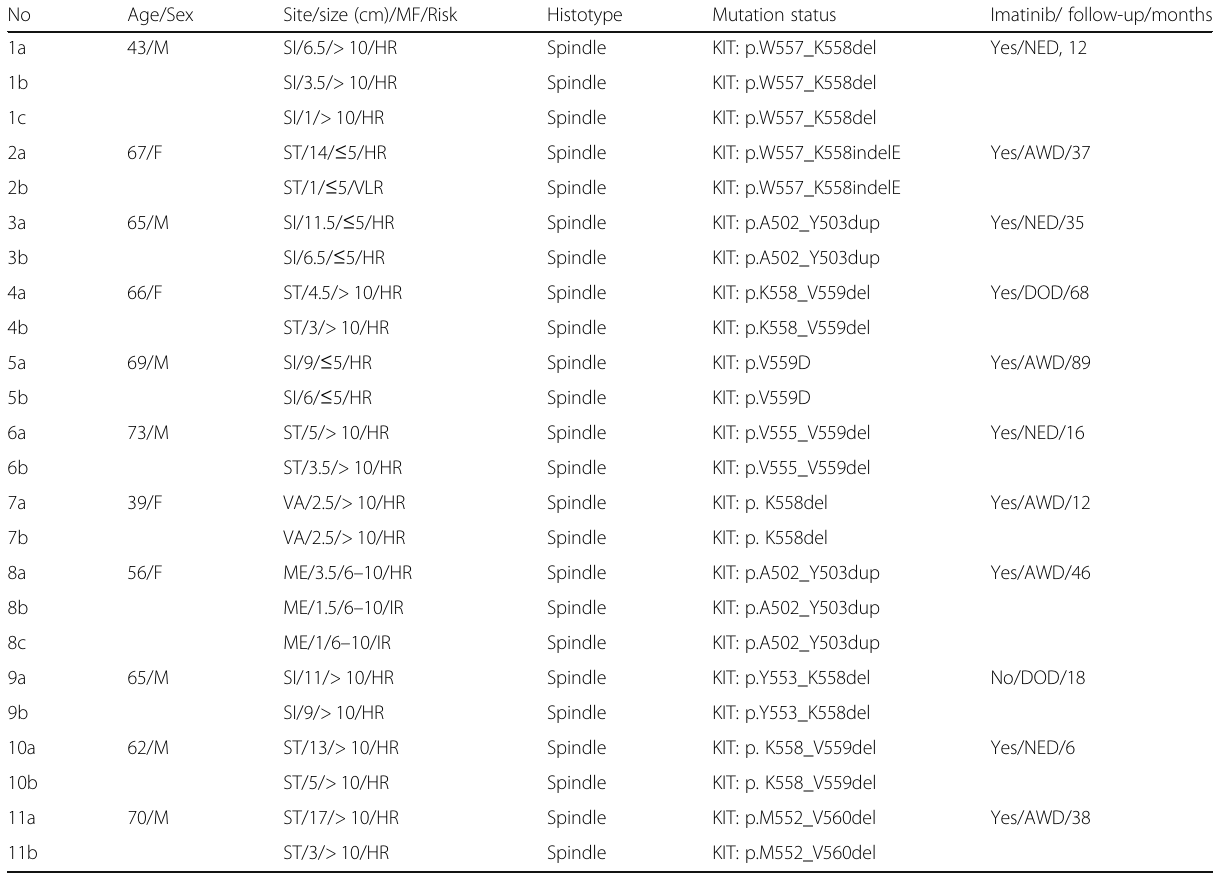
Table 2 Clinicopathologic and molecular features of 11 patients with metastatic GISTs mimicking multiple sporadic GISTs